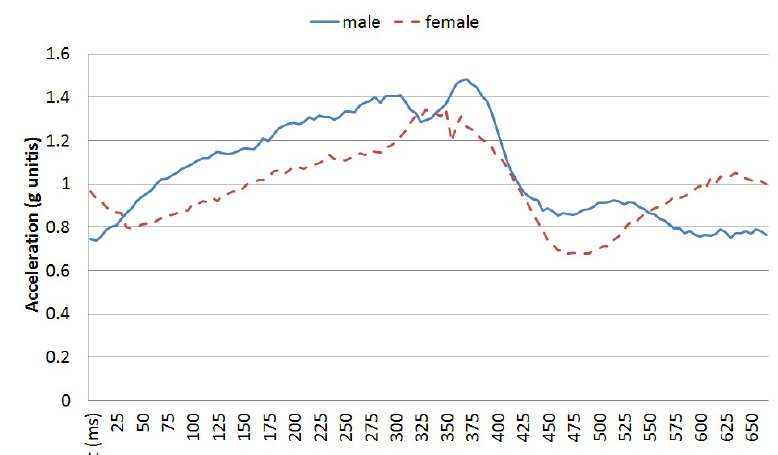
Figure 4. Vertical acceleration in a single step for one male and one female participants at 100 steps per minute.